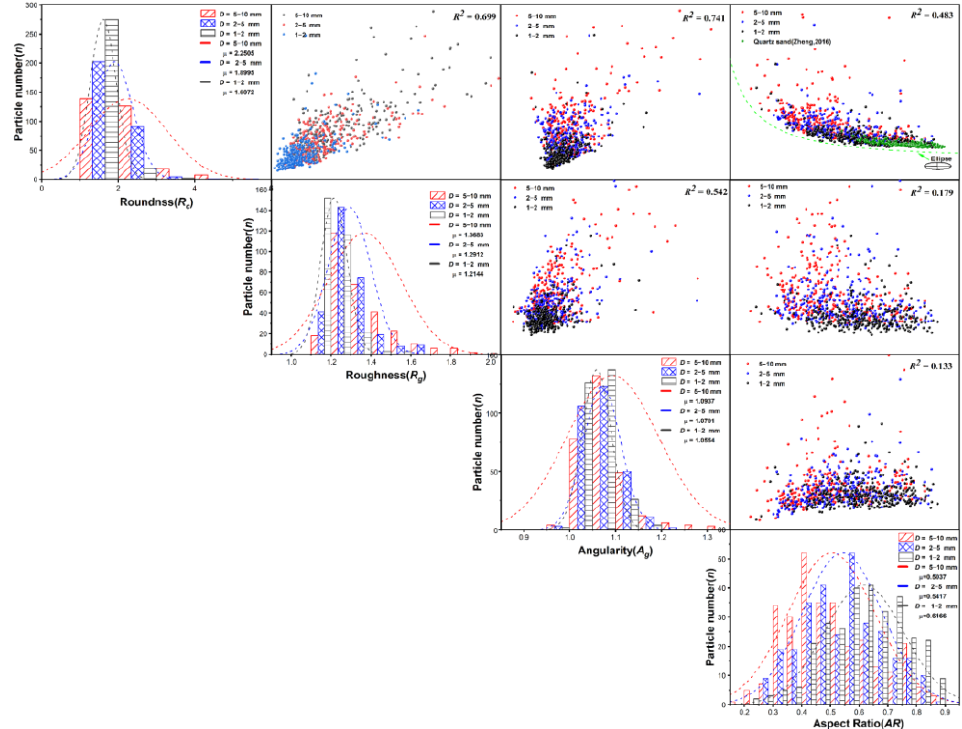
Figure 6. The distribution of four particle shape parameters and the relationships between each two of the parameters.